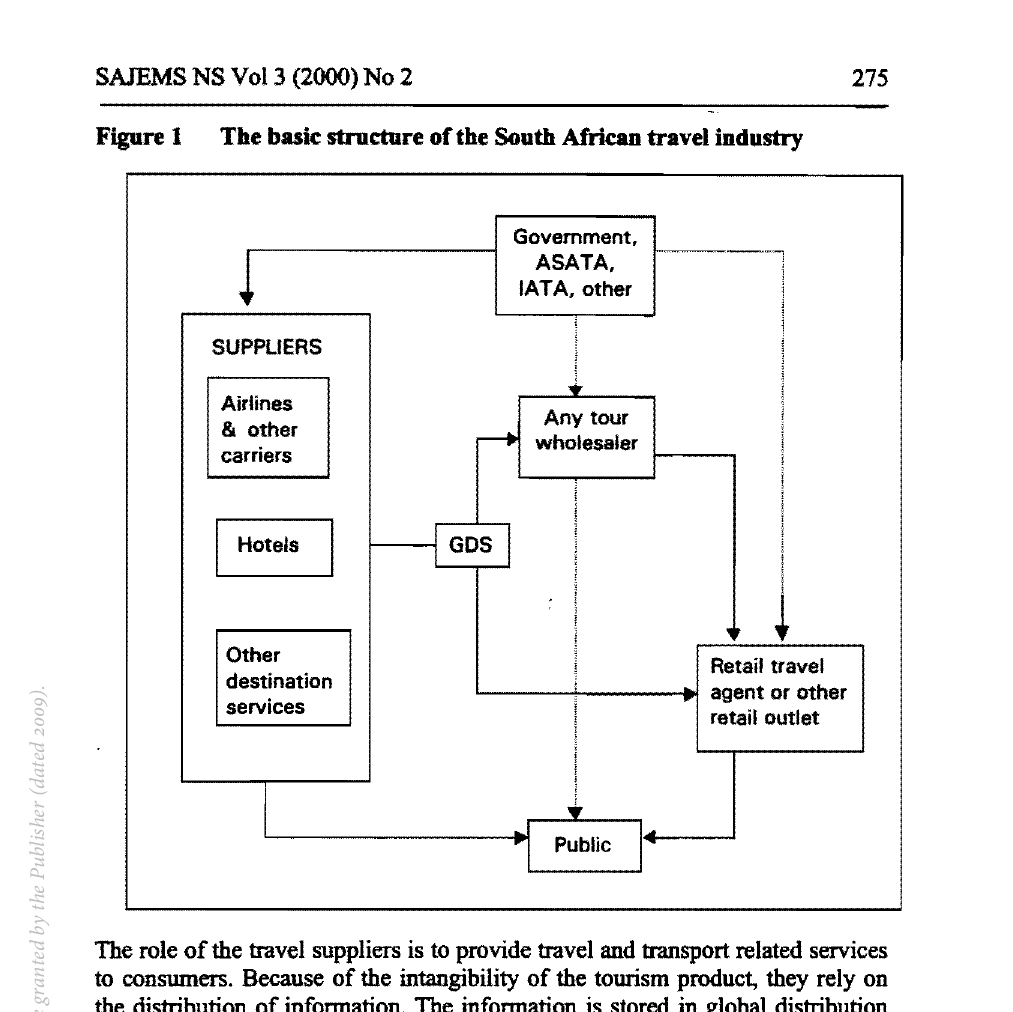
The hasic structure of the SGutb African travel industry